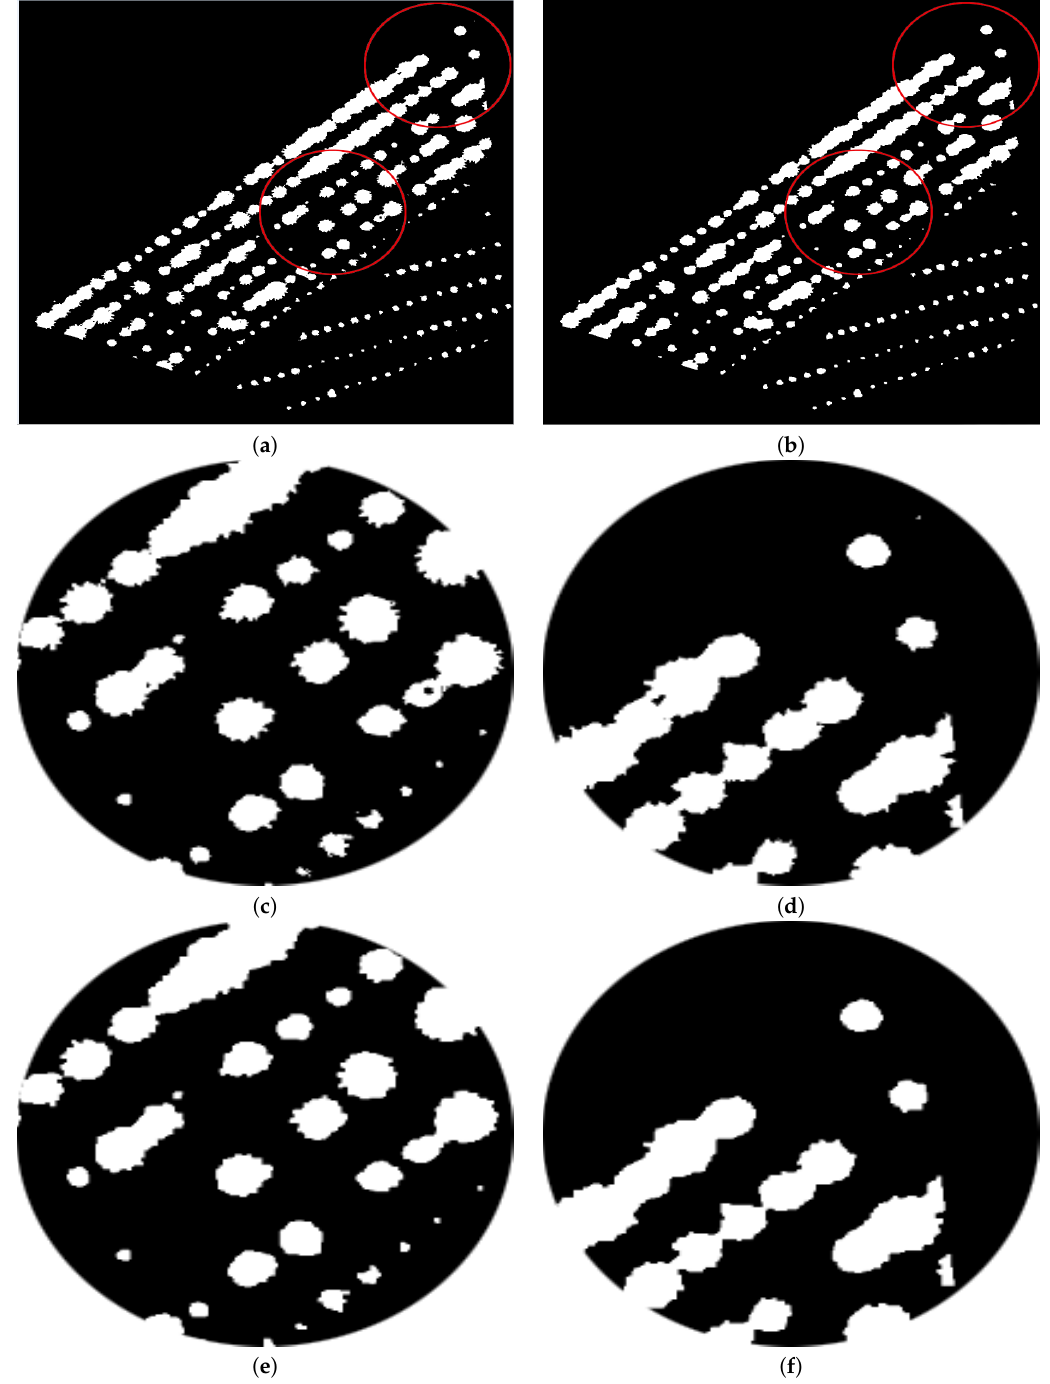
Figure 9. Preprocessing step: ( a ) binarization, ( b ) preprocessed image I c , ( c ) enlarged image of the lower surrounded region in ( a ), ( d ) an enlarged image of the upper surrounded region in ( a ), ( e ) the result of removing and cleaning the region in panel ( c ), and ( f ) the result of removing and cleaning the region in panel ( d